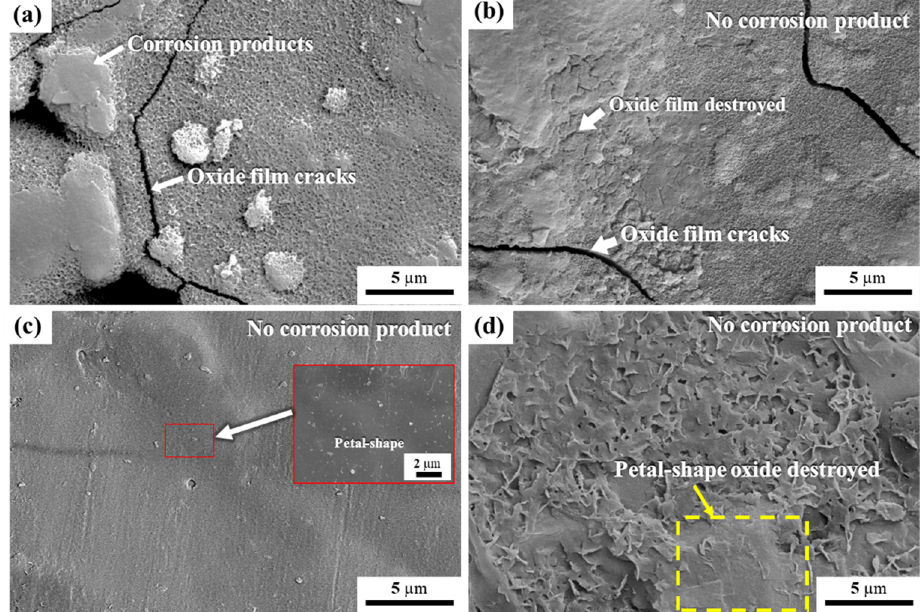
Figure 13. Surface morphology of the anodized and sealed samples after salt spray test: ( a ) 2-N; ( b ) 4-N; ( c ) 2-S; and ( d ) 4-S (SEM).